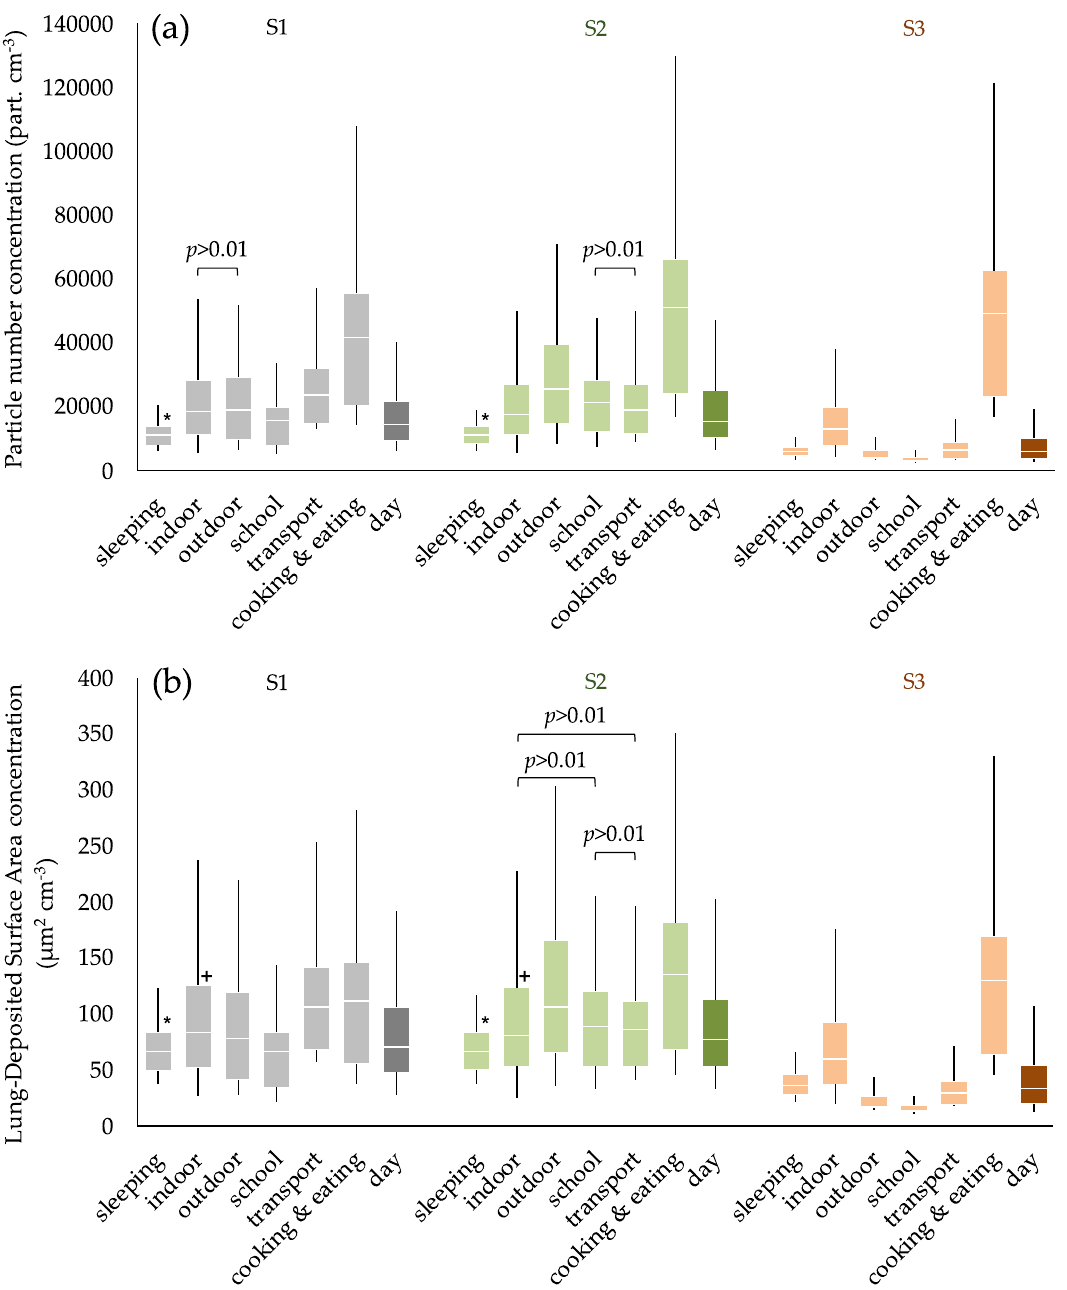
Figure 1. Statistics of ( a ) particle number and ( b ) lung-deposited surface area concentrations experienced by three groups of children (attending school S1, S2, and S3) in each microenvironment. Data was not statistically di ff erent within each group of children (S1, S2, S3) and amongst the same microenvironments of di ff erent groups (*, + ) are also indicated ( p > 0.01).